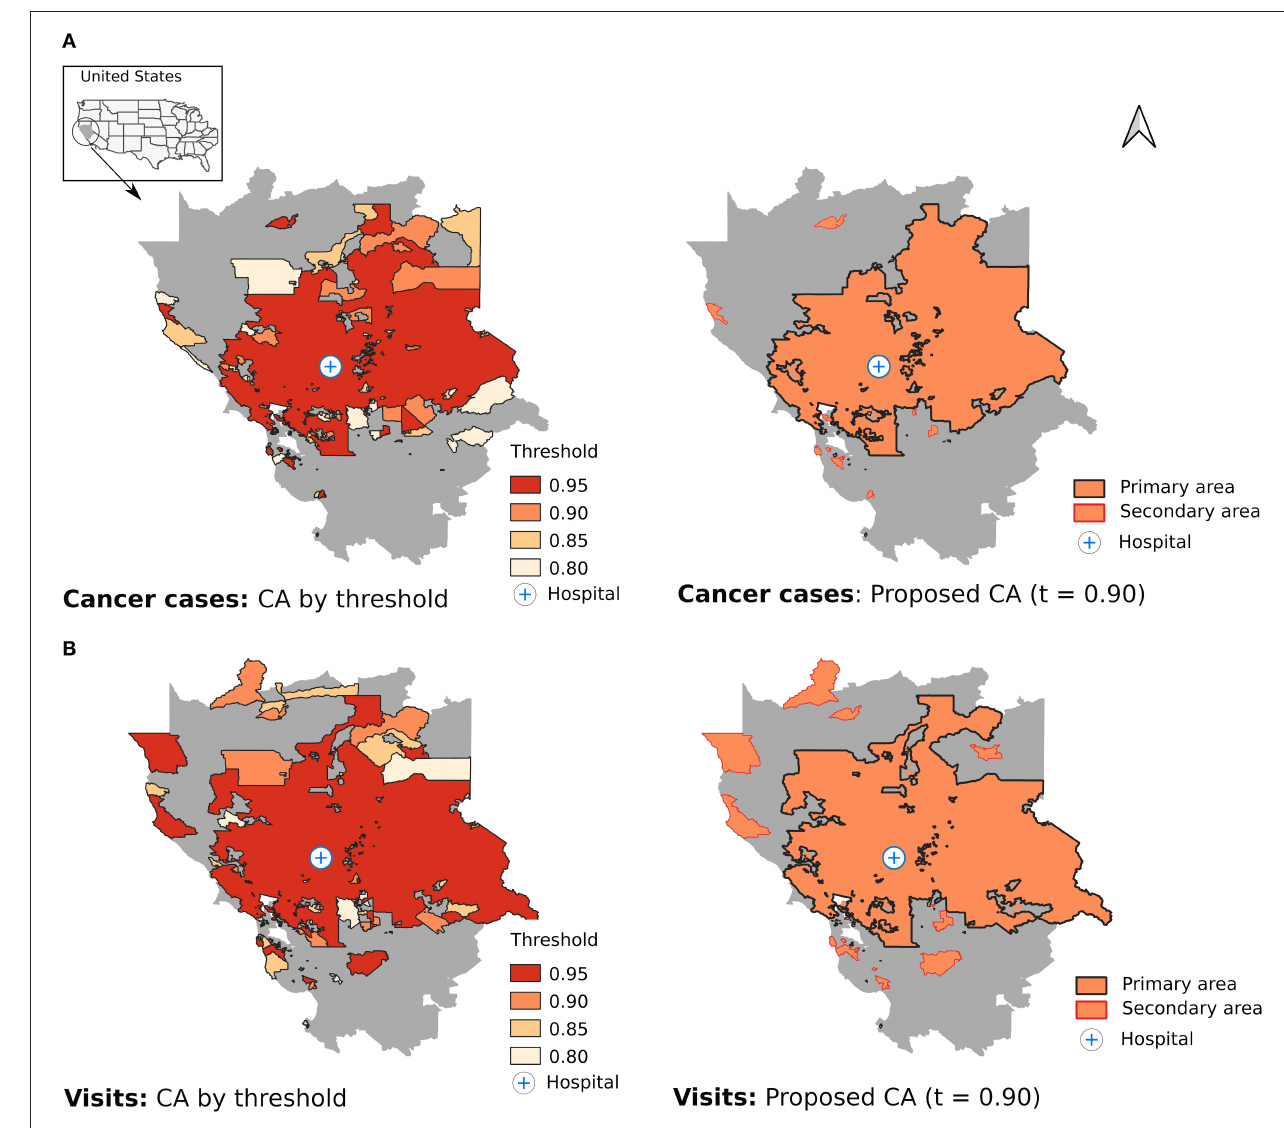
FIGURE 1 | Estimation of the catchment area using different thresholds for the exceedance probabilities (left) and proposed catchment area with a threshold of 0.90 (right) for cancer cases (A) and visits (B) .